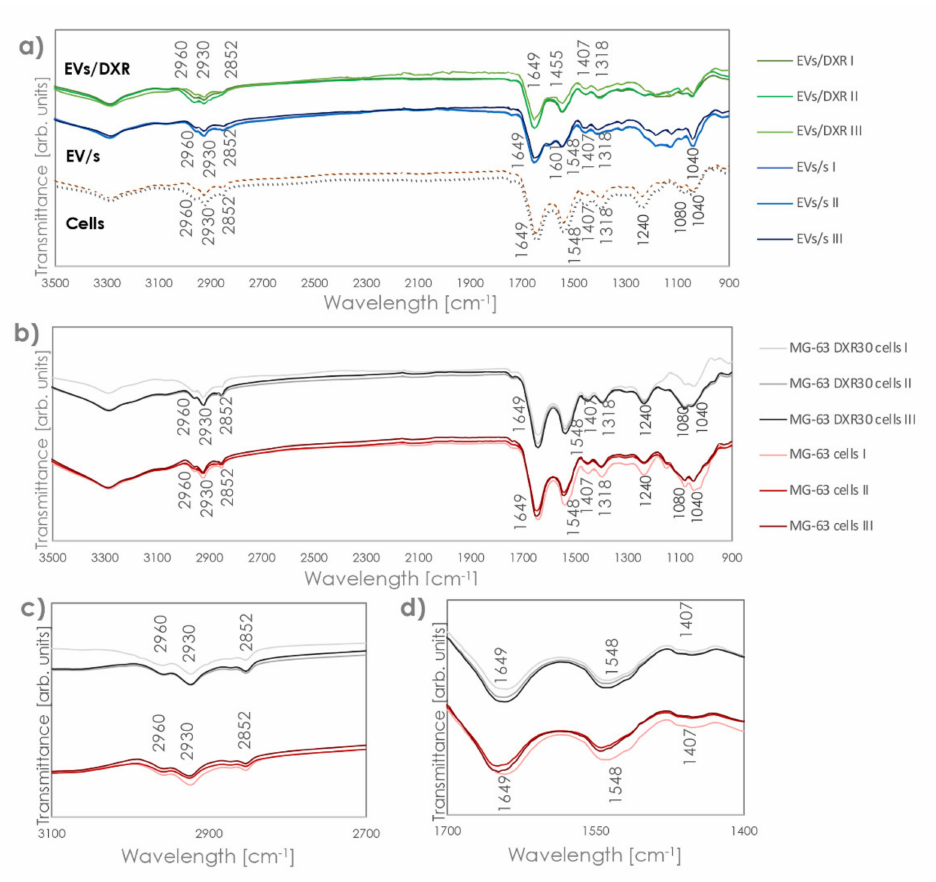
Figure 3. FT–IR/ATR spectra of EVs/s, EVs/DXR, and cells from which they are derived. ( a ) FT–IR spectra after subtracting the PBS reference curve of OS cells and OS derived–EVs. ( b ) FT–IR spectra of OS sensitive and drug-resistant cells. Panels ( c , d ) highlight the band region corresponding to protein and lipid zones,